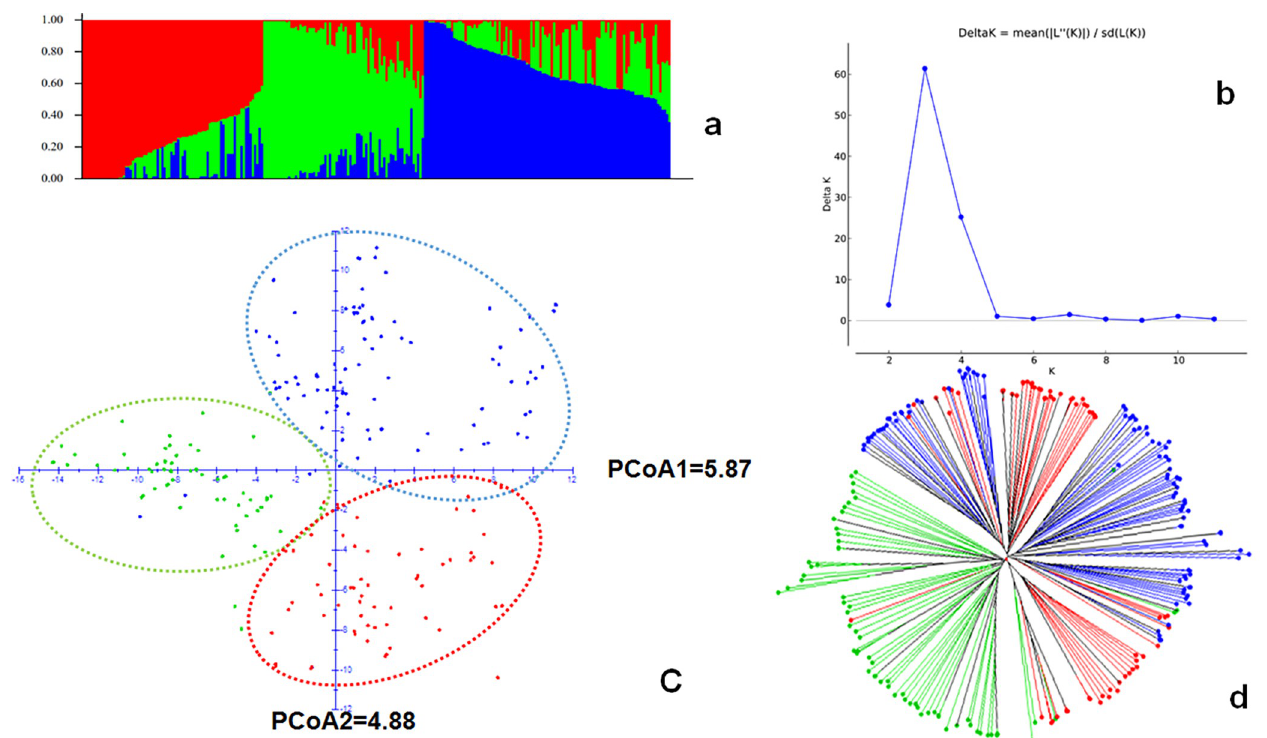
Fig 3. Population structure analysis for the 260 Ethiopian barley accessions. a) bar plot for estimated population structure of 260 Ethiopian barley accessions based on inferred three clusters (red = cluster 1, green = cluster 2, and blue = cluster 3); b) Structure harvester Delta K ( Δ K) = 3; c) results of principal coordinate (PCoA) analysis, accessions were assigned based on their highest probability of inferred clusters; and d) weighted neighbor-joining tree for the structured subpopulations (red = cluster 1, green = cluster 2, and blue = cluster 3). https://doi.org/10.1371/journal.pone.0260422.g003 was also assigned to cluster 3, but the low number of accessions has to be taken into account. Principal coordinate analysis (PCoA) indicated that PCoA1 and PCoA2 explained 5.87% and 4.88% of the variation, respectively. Despite these values being rather low, the high genetic var- iation within the set of accessions is reflected by the inferred three clusters (Fig 3C).